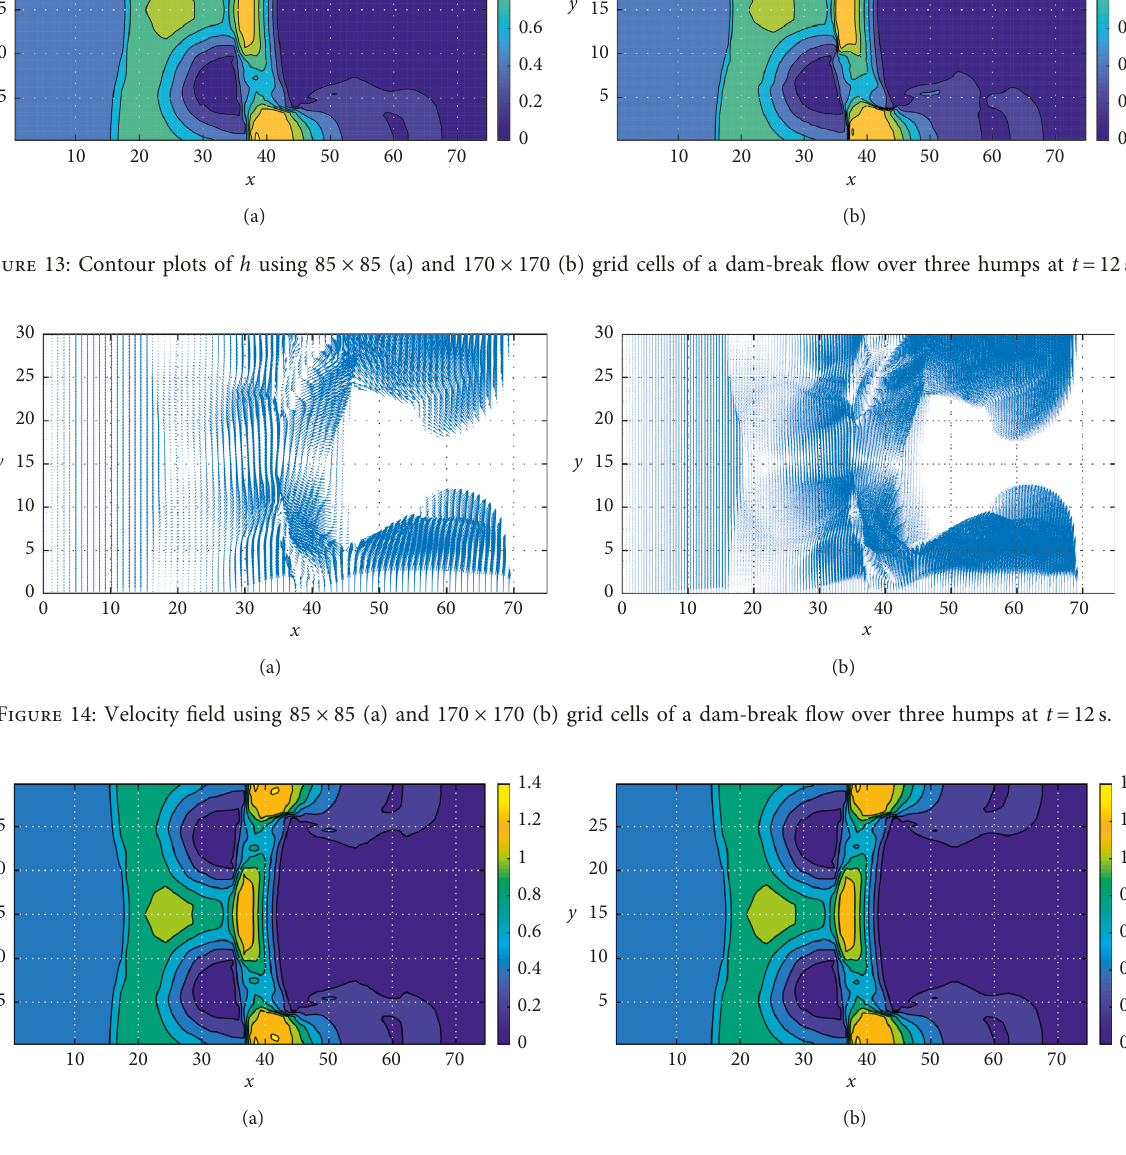
85 grid cells from scheme I (a) and scheme II (b) of a dam-break flow over three humps at t ×